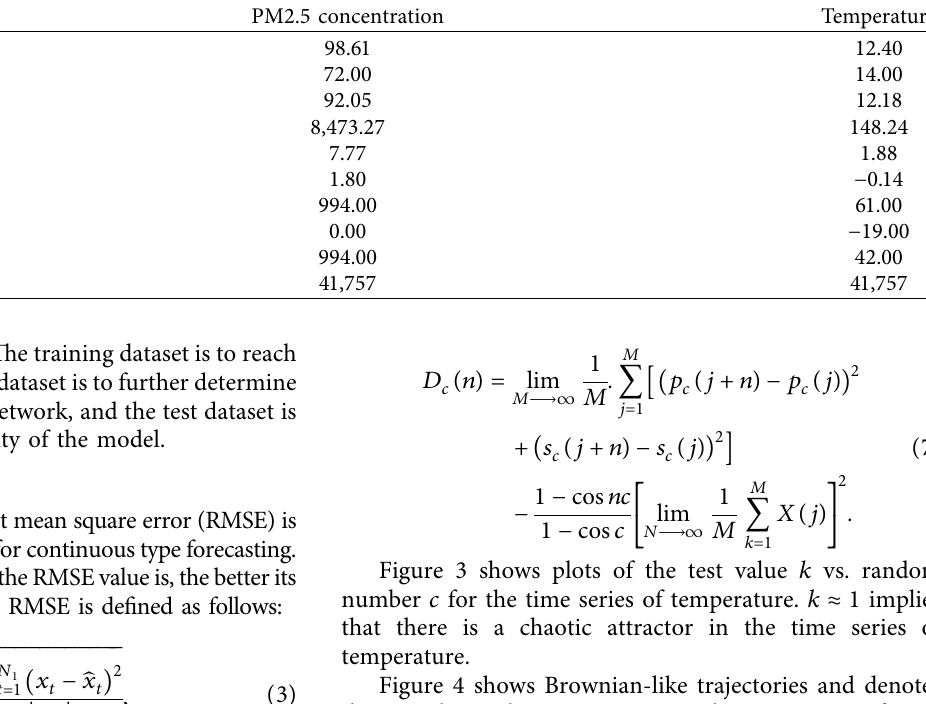
Table 1: Descriptive statistics for PM2.5 concentration and